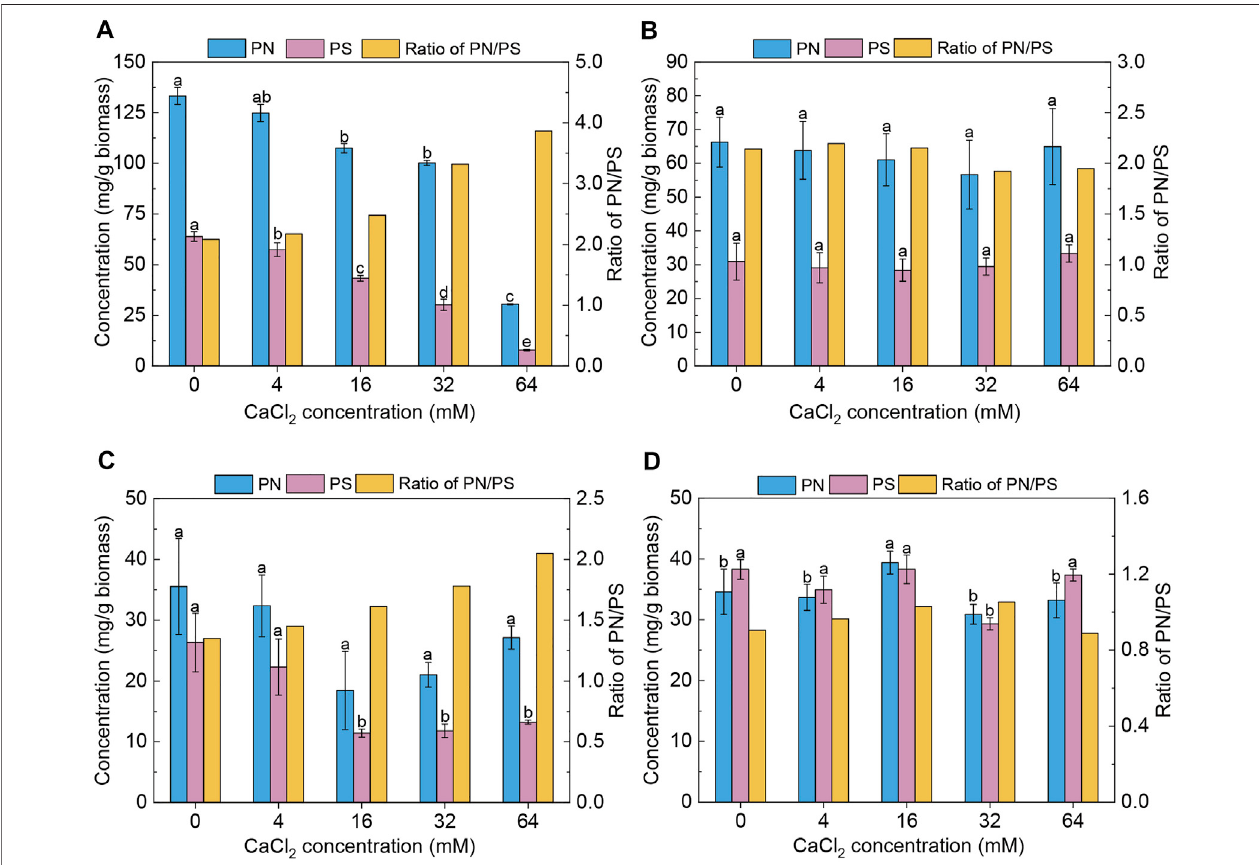
FIGURE 4 | Effects of adding CaCl 2 on protein (PN) content, polysaccharide (PS) content, and the ratio of protein to polysaccharide (PN/PS) in the EPS of both bio fi lms and planktonic cells. (A,B) Bio fi lms and planktonic cells of Pseudomonas sp. ZX01 (C,D) Bio fi lms and planktonic cells of Arthrobacter sp. ZX07. Bars represented mean ± standard deviation of three replicates. Different lowercase letters labeled on the bars represented the signi fi cant difference ( p < 0.05) according to the one-way ANOVA and multiple comparisons.